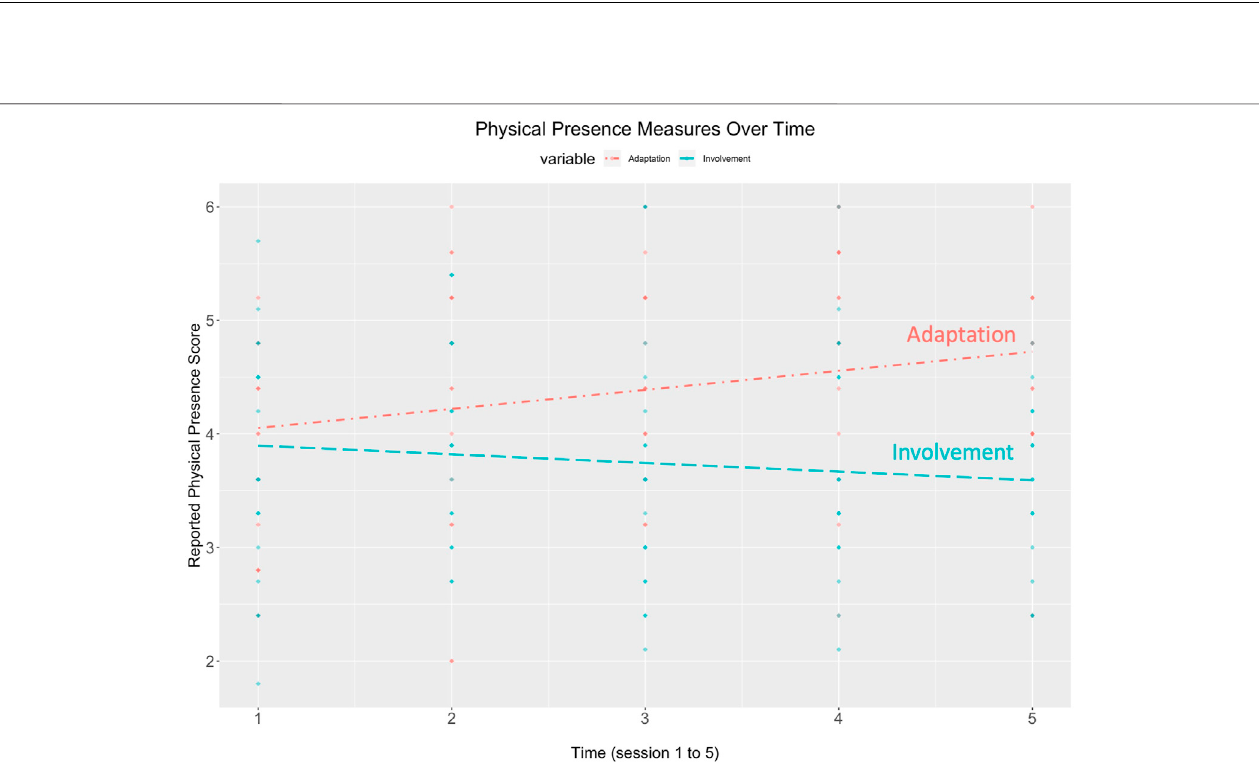
FIGURE 11 | Ratings of physical presence-Adaptation and Involvement over time.